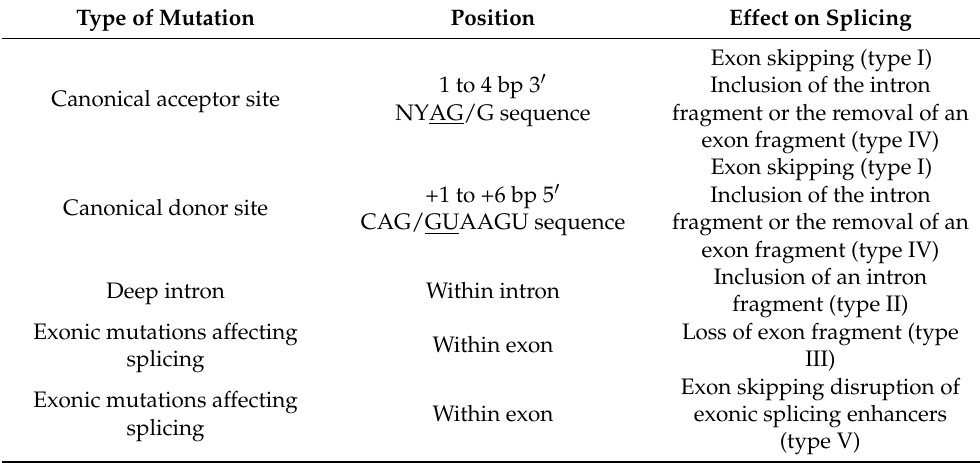
Table 3. Classification of splicing variants and the predicted effect. Underlined, the position is considered to be the most classical canonical site (+/ − 1 and